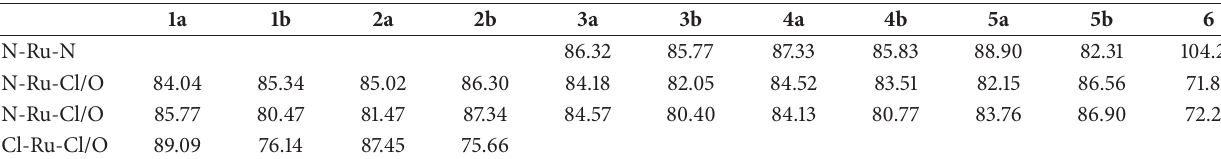
Table 2: Selected bond angles of interest in the